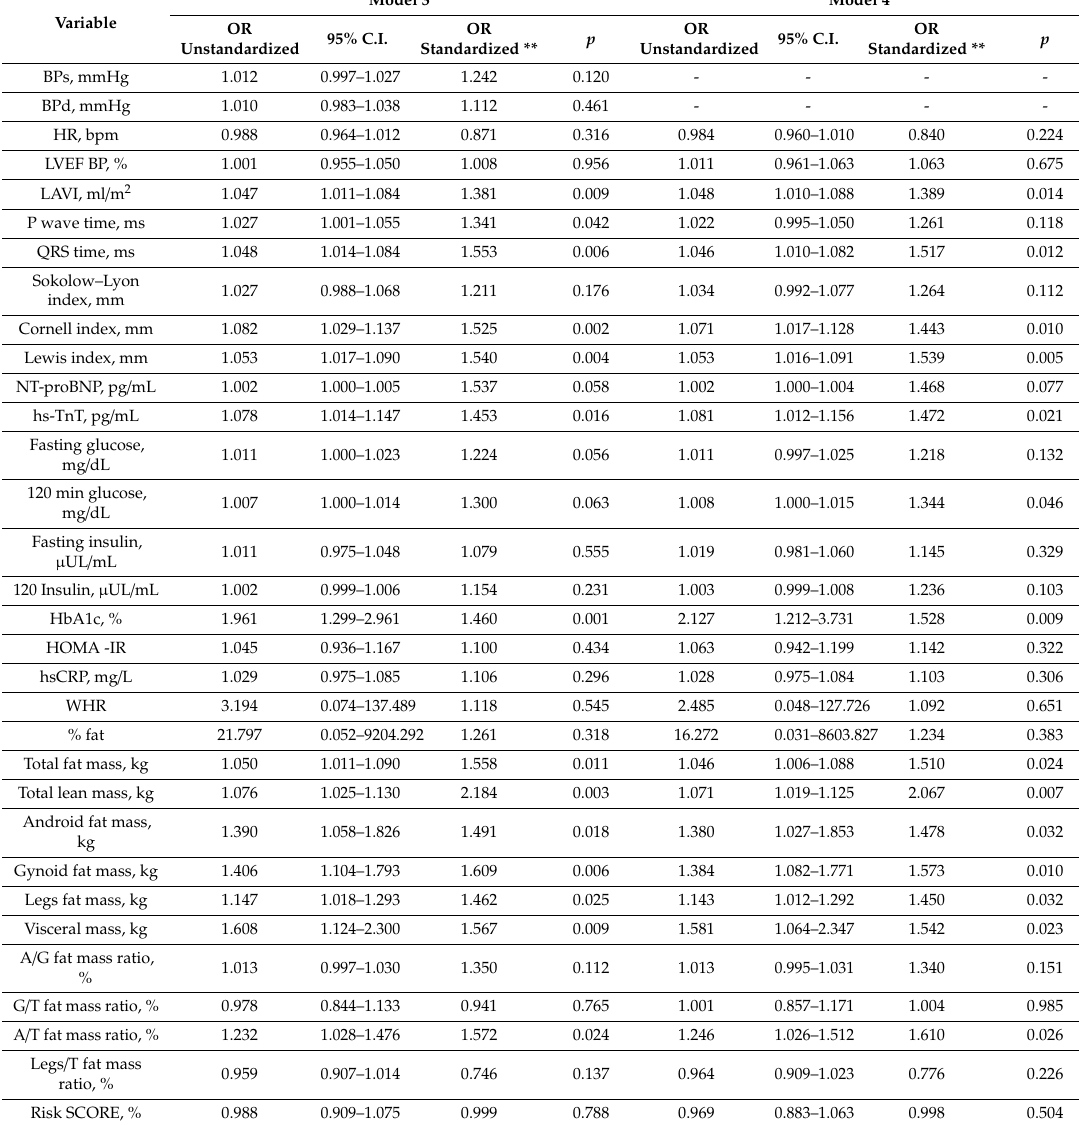
Table 5. Results of the left ventricular hypertrophy * multivariable logistic regression analysis in the study